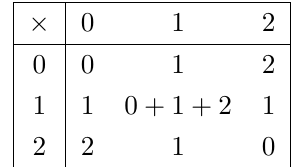
Table 3 . Fusion rules at level k = 4 for the integer